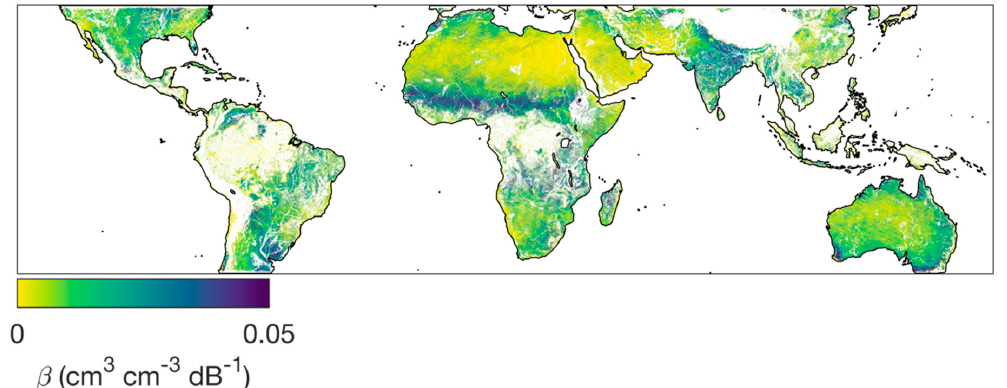
Figure 7. The slope of the linear regression between CYGNSS effective reflectivity observations and SMAP soil moisture ( 𝛽 ). This represents the sensitivity of CYGNSS to soil moisture, with lower values indicating a higher sensitivity—though low values are also found in regions where soil moisture does vary significantly. Higher values of 𝛽 mean that CYGNSS observations are not as sensitive to soil moisture. Imperfect open water masking will cause an apparent insensitivity to soil